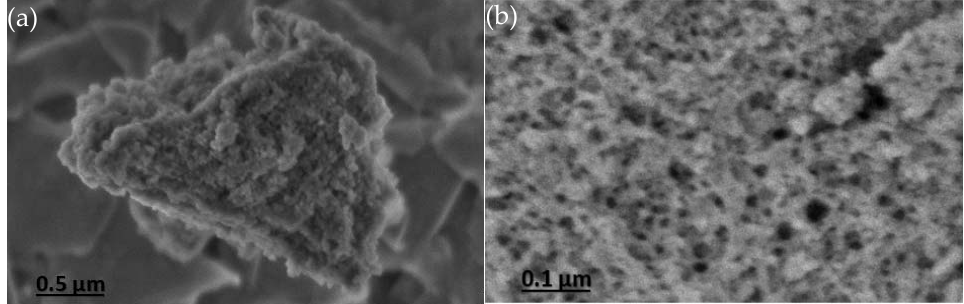
Figure 3. SEM images of the 0.3NH 2 / DMS-1 adsorbent showing ( a ) irregular shape of the particle, and ( b ) the disordered structure of the mesoporos.